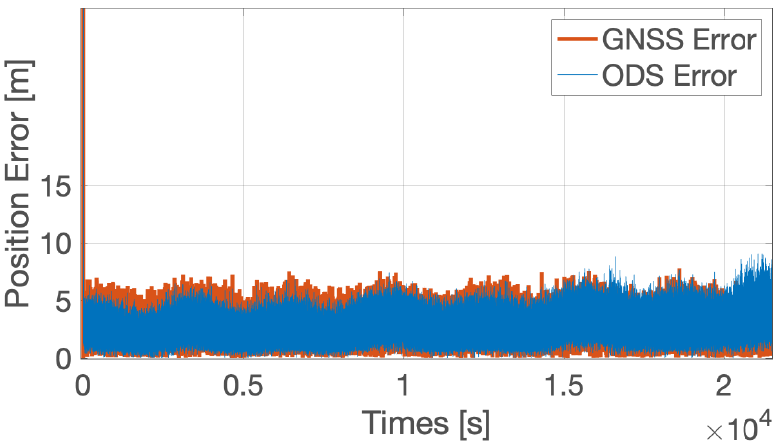
Figure 7. Position error in MIL analysis of